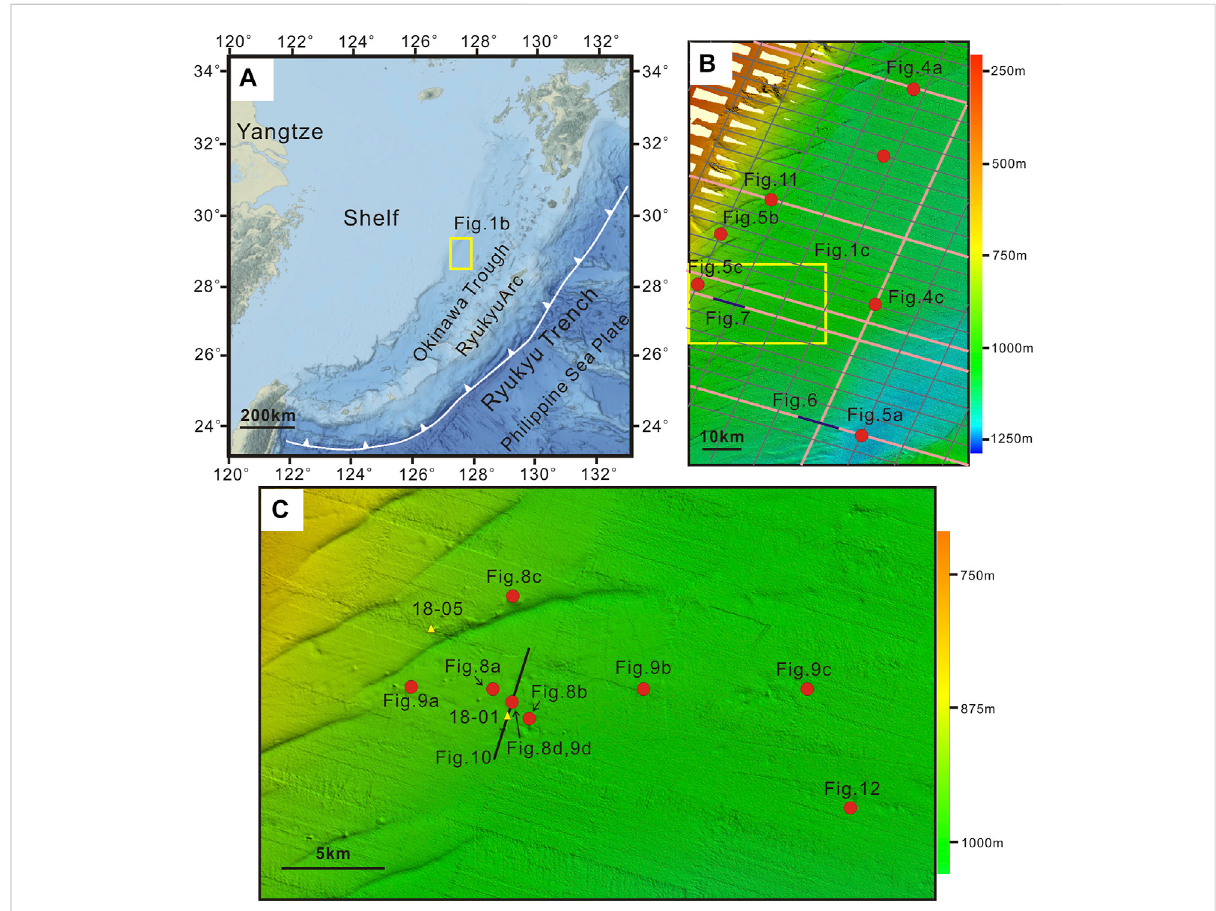
FIGURE 1 (A) PhysiographicmapofthesurroundingseaofOkinawaTrough.Thestudyareaisshownwithayellowbox. (B) Thelocationofseismiclinesin black lines and multibeam data in colors. The pink lines denote the locations of seismic lines used in the paper. (C) Magni fi ed multibeam data. The location is shown in Figure 1b in the yellow box. For simplicity and clarity, except for Figures 6, 7, 10 we just labeled the location of the geophysical features in each fi gure with red